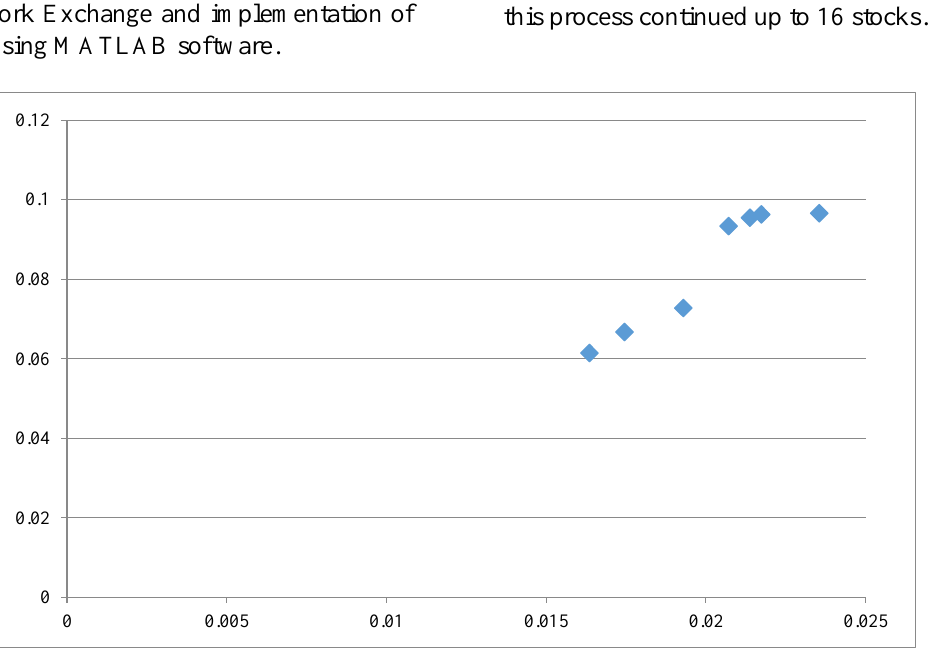
Figure 4. Efficient frontier with constraint of selecting 8 stocks from 20 ones for LPM model with Rnec=